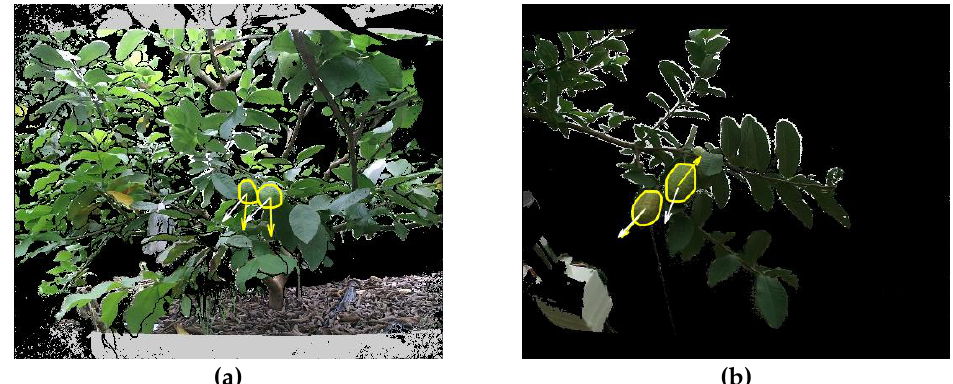
Figure 11. Failure examples. The yellow array represents the estimated pose, while the white array is the ground-truth pose.